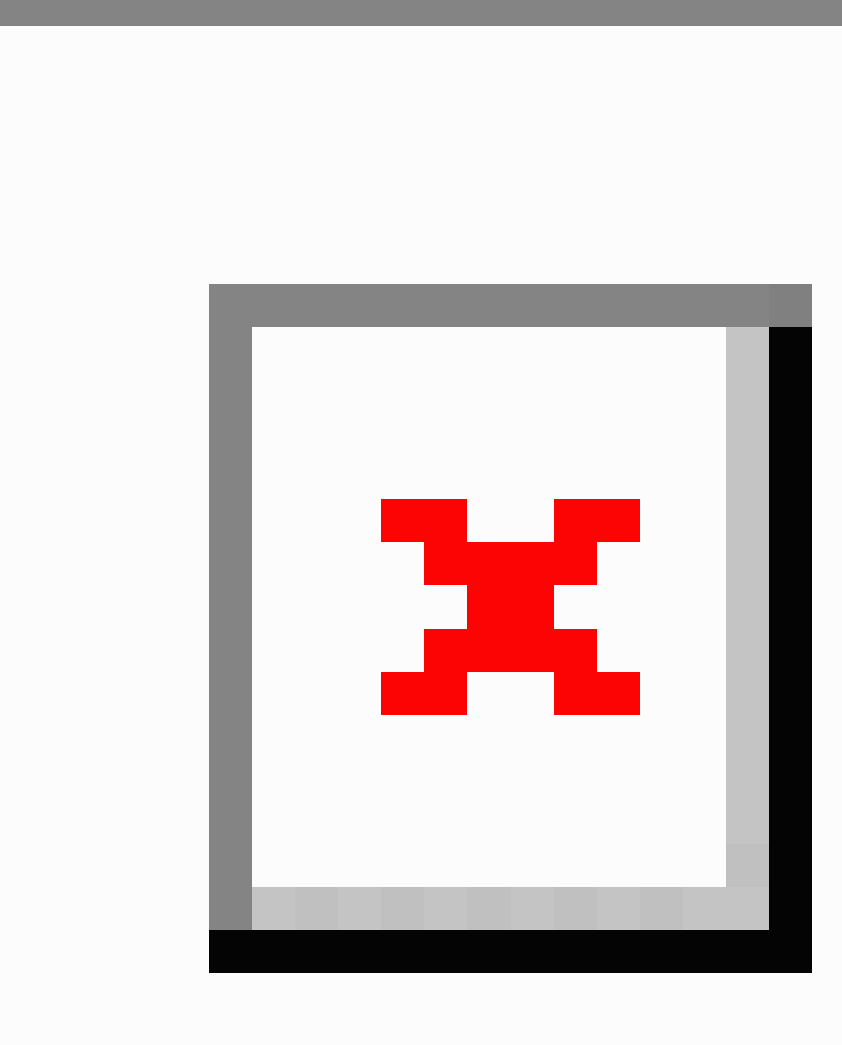
Figure 3. Intervention flow